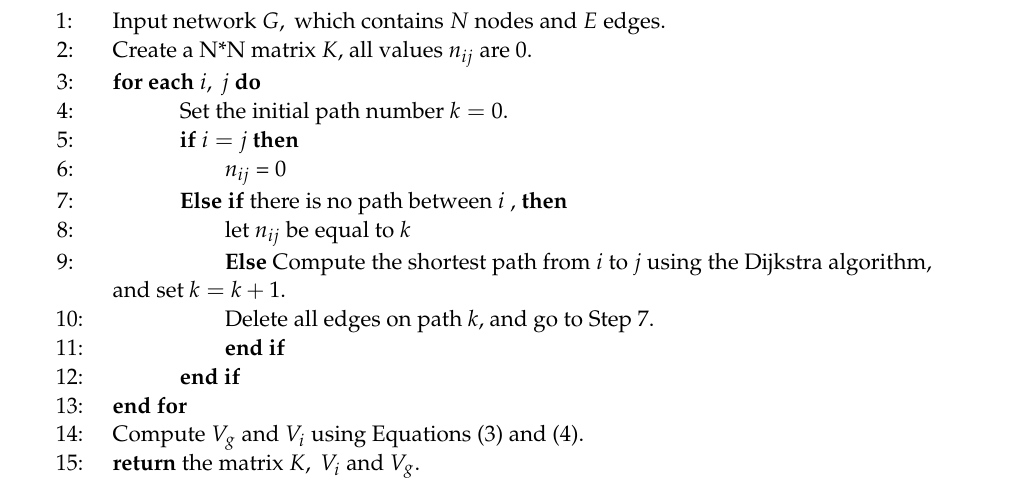
Algorithm 1: Network and Node